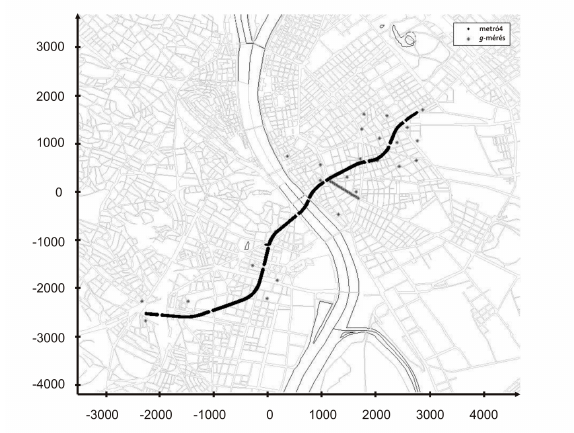
Figure 3. The tunnel (black line interrupted at the stations) and the gravimetric points (grey stars) with main structures of Bu- dapest in the background. The axes are in meter, referring to coordinates in the Budapest Municipal Projection sys- tem.